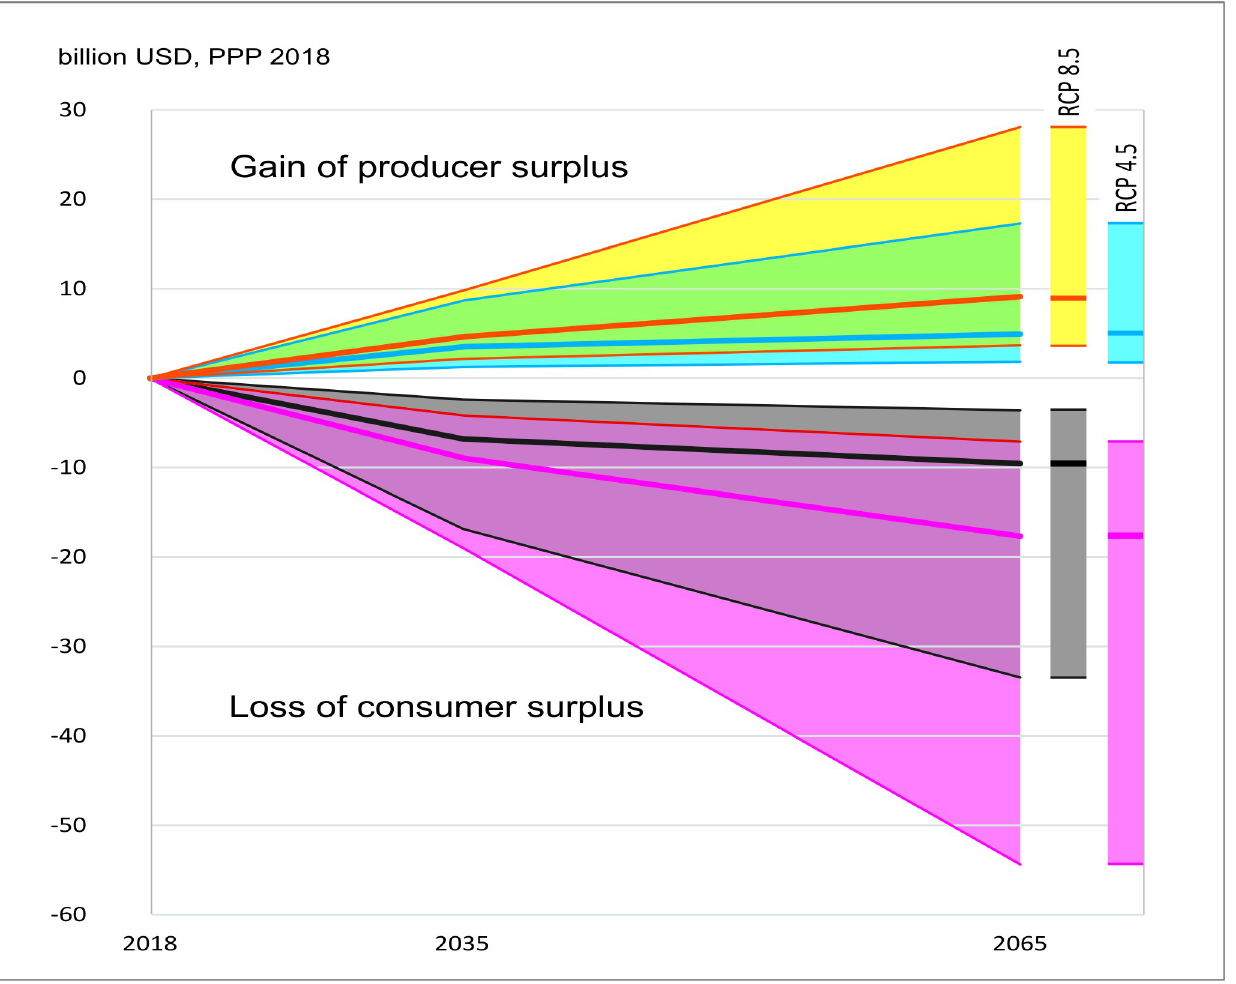
Fig 4. The welfare changes of fishery consumers and producers due to climate change by 2035 and 2065, relative to 2018.